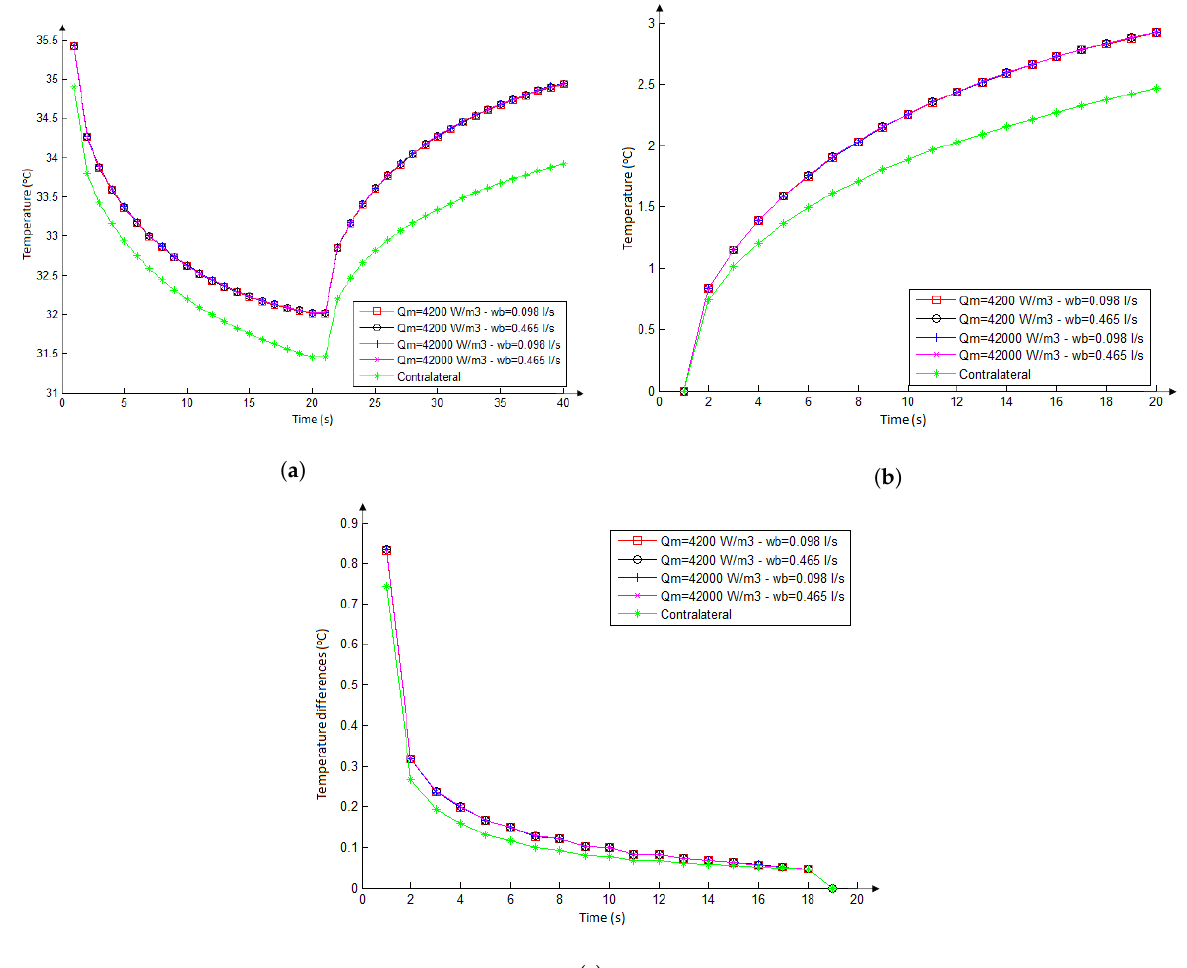
Figure 12. Influence of the metabolic heat and blood perfusion rate at transient state for possible combinations of nodular properties in front of it and on the symmetric neck position (on the red circle and cyan diamond of Figure 7a). Considering all simulation time ( a ). The reheating stage considering all curves starting at the same temperature ( b ). The difference between consecutive temperatures, representing the heating rate ( c